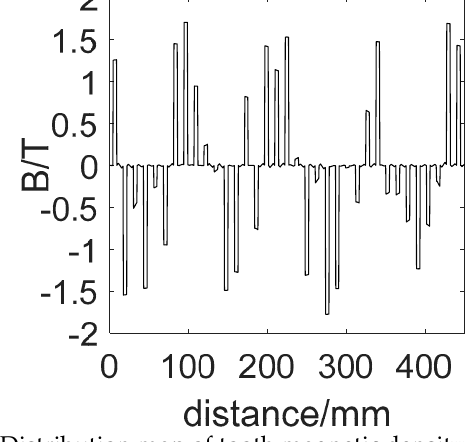
Figure 16. Tooth magnetic density distribution map of stator winding corresponding to different starting modes.